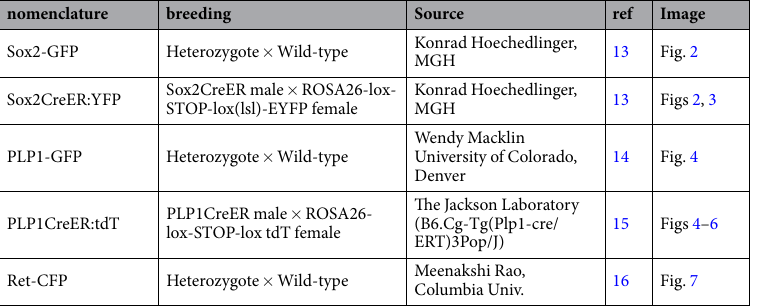
Table 1. Mouse models used in the current work.